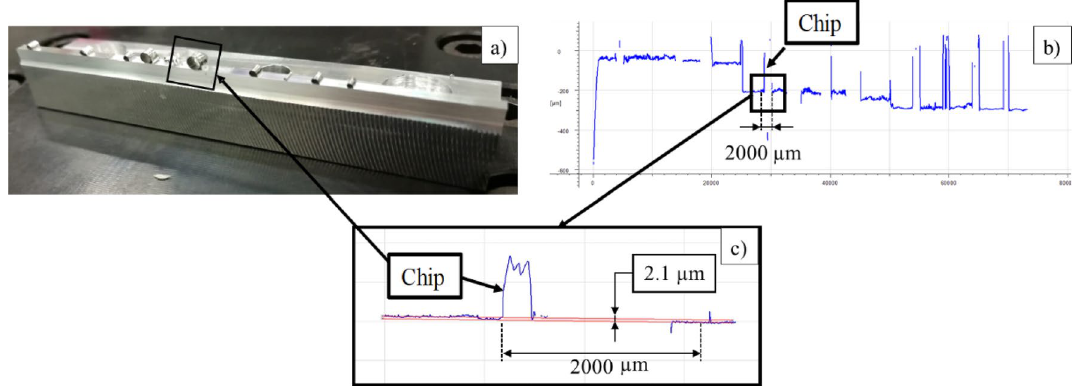
Figure 10. ( a ) A workpiece with multiple quick-stops, ( b ) overview profile obtained with the Alicona IFG4 at 20X and ( c ) detailed profile of the selected area at higher resolution